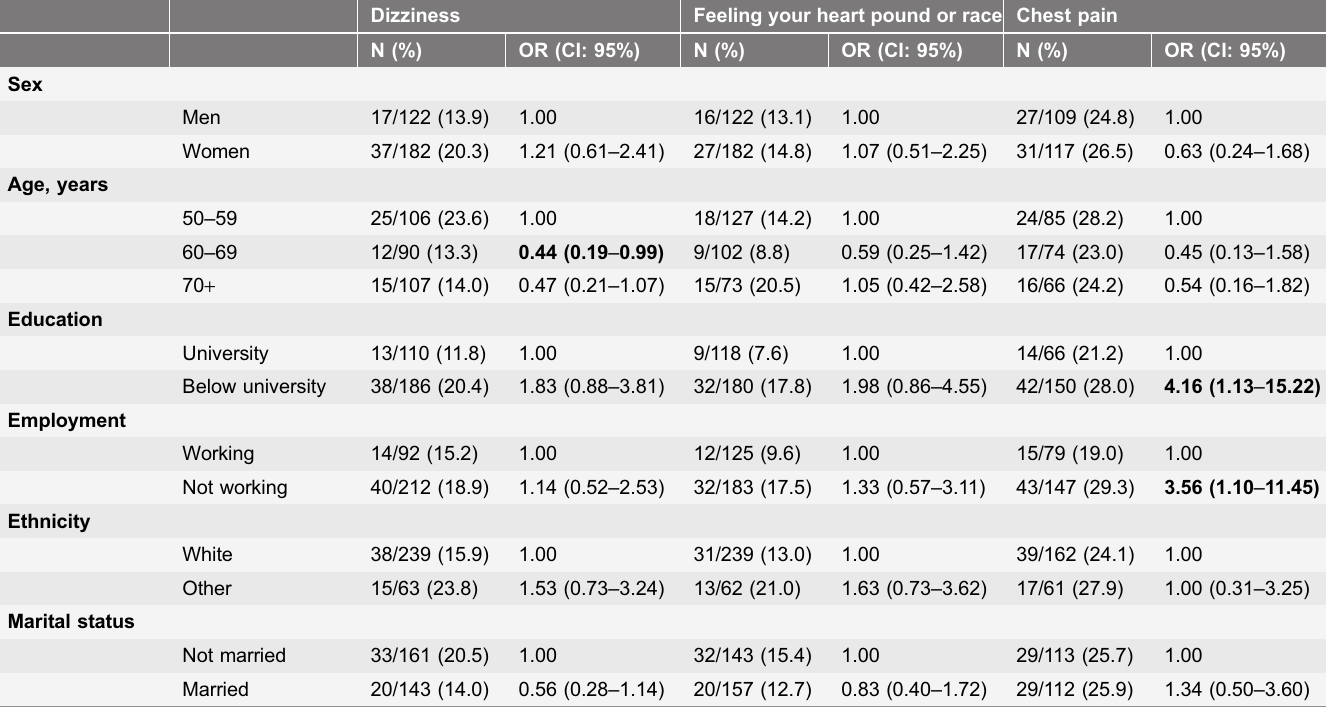
Table 7. Prevalence and adjusted odds ratios of reporting higher perceived seriousness for dizziness, feeling your heart pound or race or chest pain in the last 3 months.*